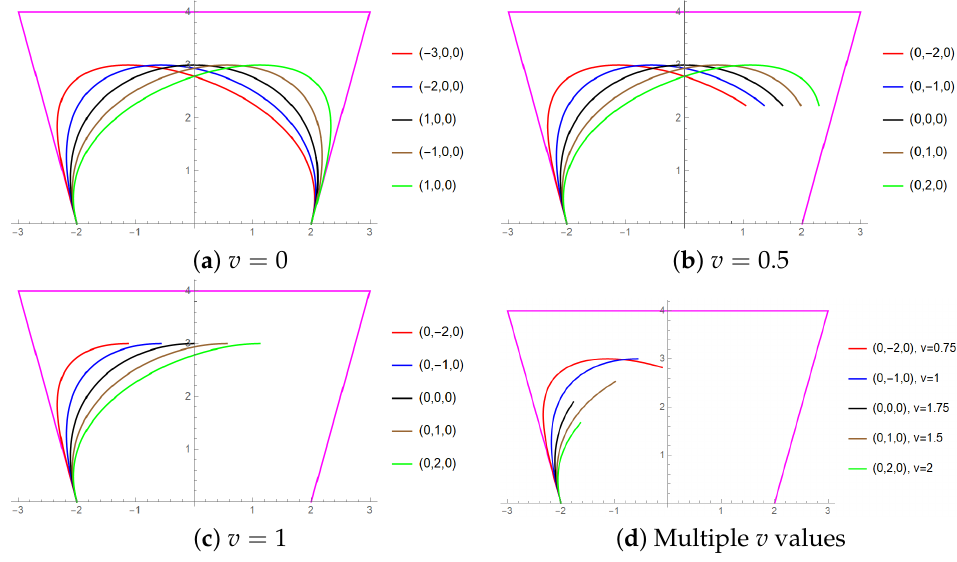
Figure 4. Cubic fractional Bézier curve with multiple values of v and a 2 shape parameter.